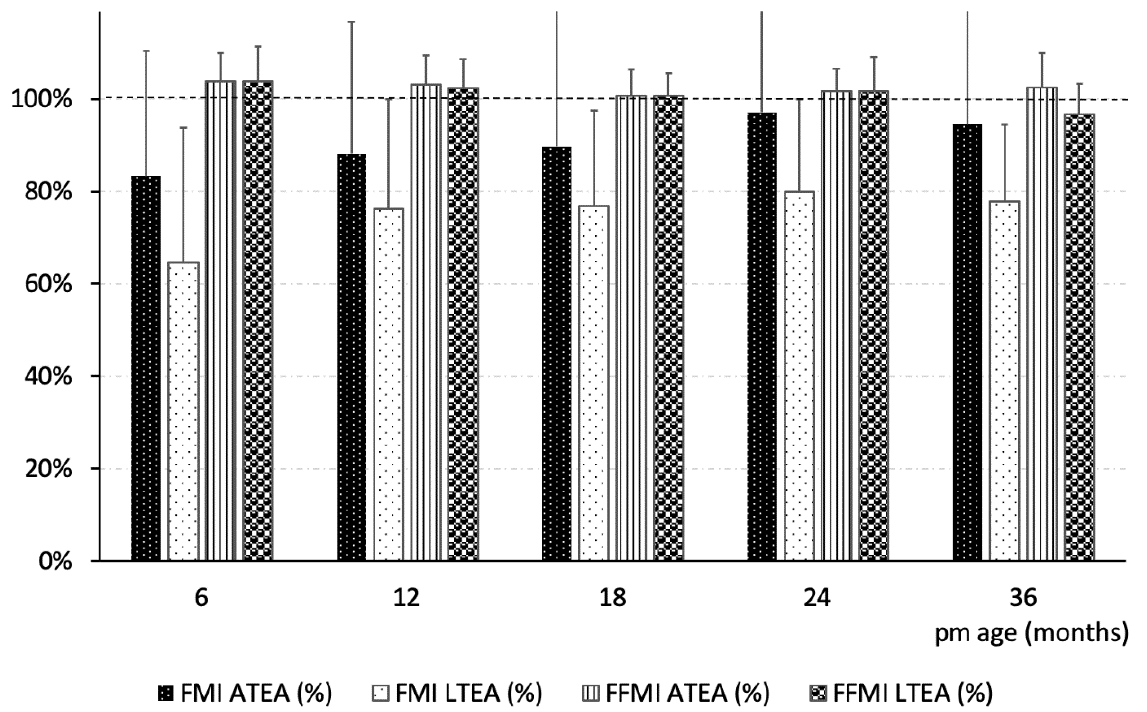
Figure 1. Time course of fat mass index (FMI) and fat free mass index (FFMI) in light and appropriate for term equivalent age (LTEA and ATEA) preterm infants as percentage of term infants.